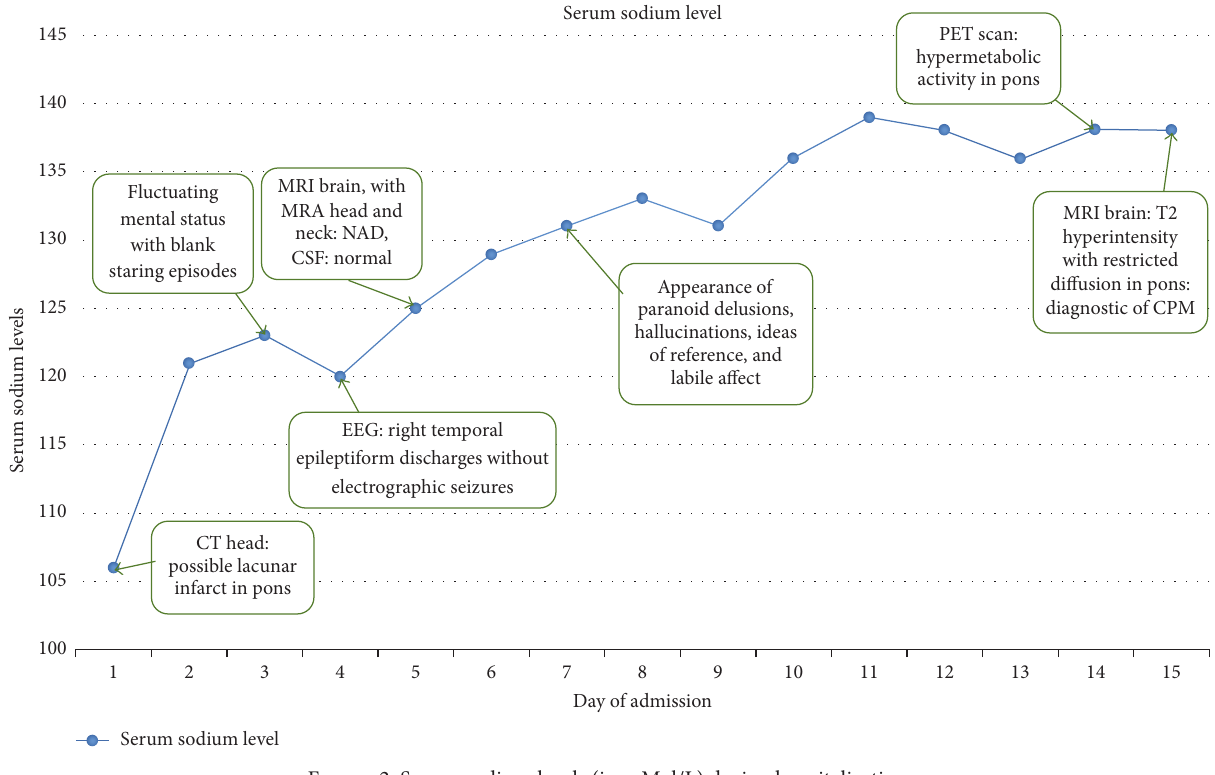
Figure 2: Serum sodium levels (in mMol/L) during hospitalization.